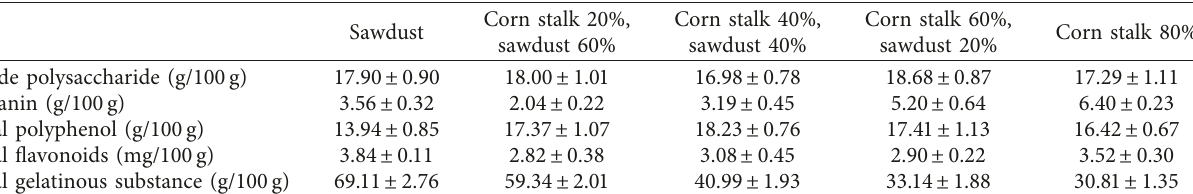
Table 3: Effect of different additions of corn stalks on the functional components of the Auricularia auricula .